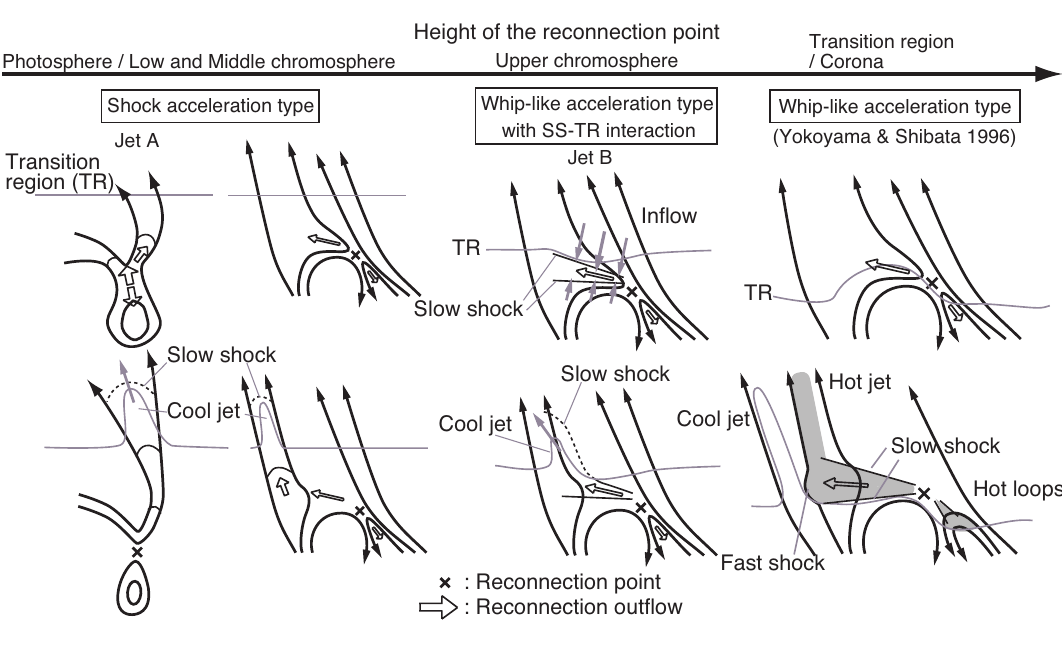
Figure 55: Schematic illustration of the acceleration mechanisms of chromospheric jets. Image reproduced with permission from Takasao et al. (2013), copyright by